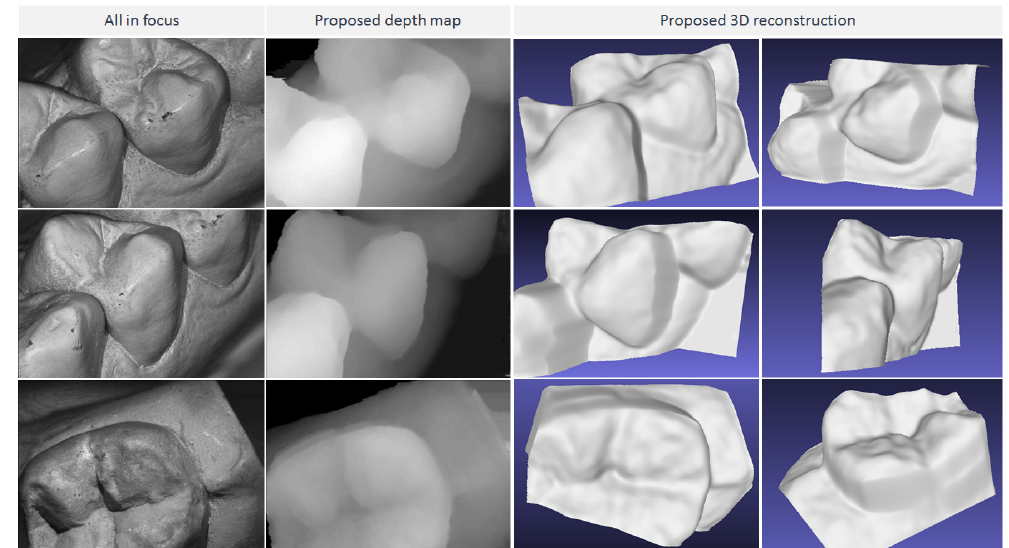
Figure 12. Depth estimation of our method on synthetic dataset.